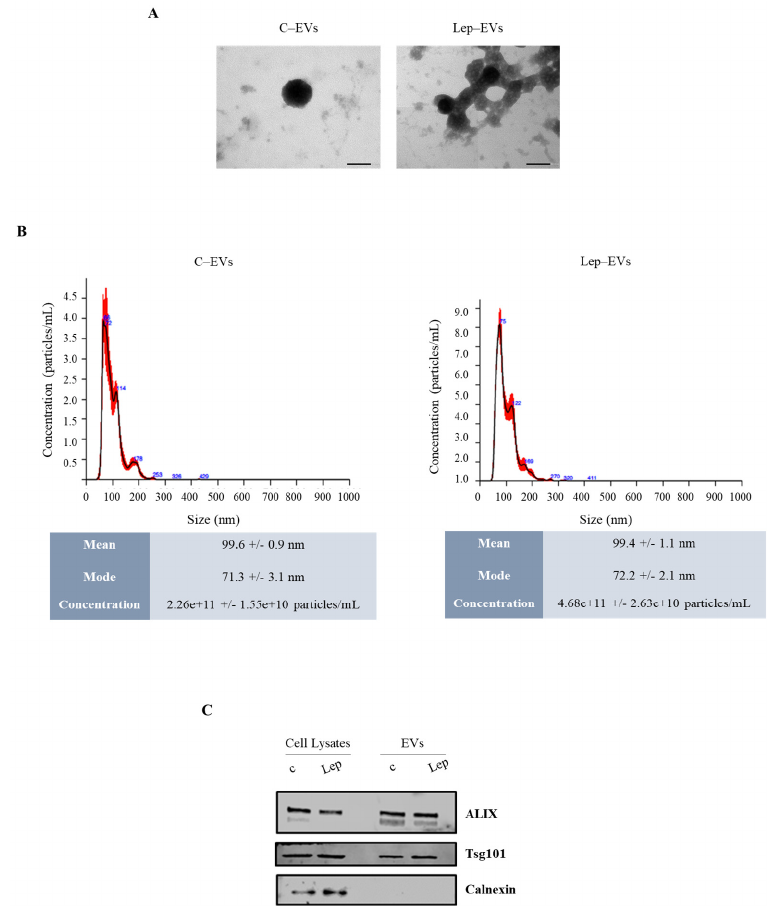
Figure 1. Characterization and quantification of extracellular vesicles (EVs) from MCF-7 breast cancer cells. EVs were isolated from conditioned media of MCF-7 after treatment with vehicle ( c ) or leptin (Lep, 500 ng/mL) for 48 h, and named C-EVs and Lep-EVs, respectively. ( A ) Representative images of transmission electron microscopy showing fields of C-EVs and Lep-EVs. Scale bar 50 nm. ( B ) Representative size distribution profiles of C-EVs and Lep-EVs, measured by nanoparticle tracking analysis. ( C ) Immunoblot analysis showing expression of the EV hallmarks Alix and Tsg101, in equal amount of whole cell lysates and EV lysates of MCF-7 cells as reported. Calnexin was used to ensure that EV samples were not contaminated with endoplasmic reticulum proteins.